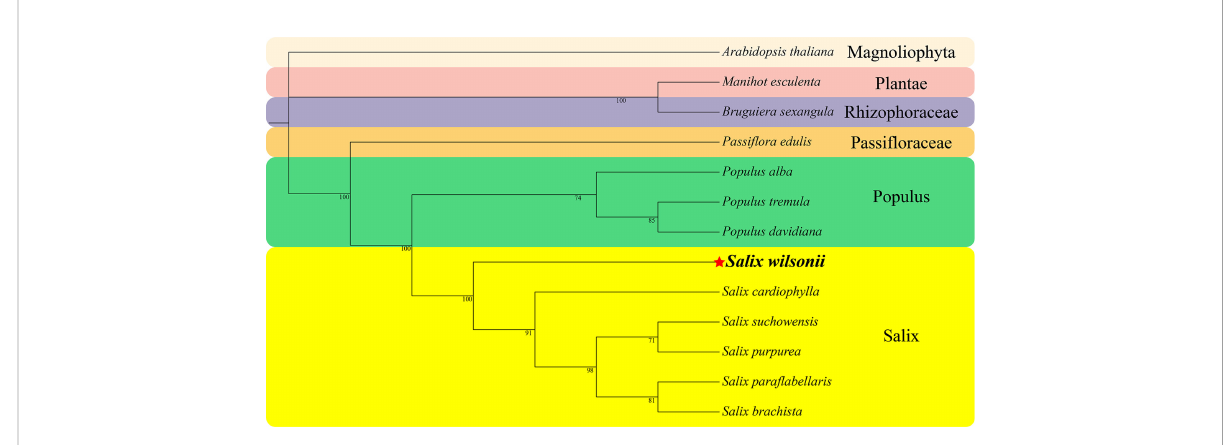
FIGURE 6 The phylogenetic relationships of Malpighiales. The number on each branch is the bootstrap support value. Colors indicate families of each species, where Populus and Salix of Salicaceae are